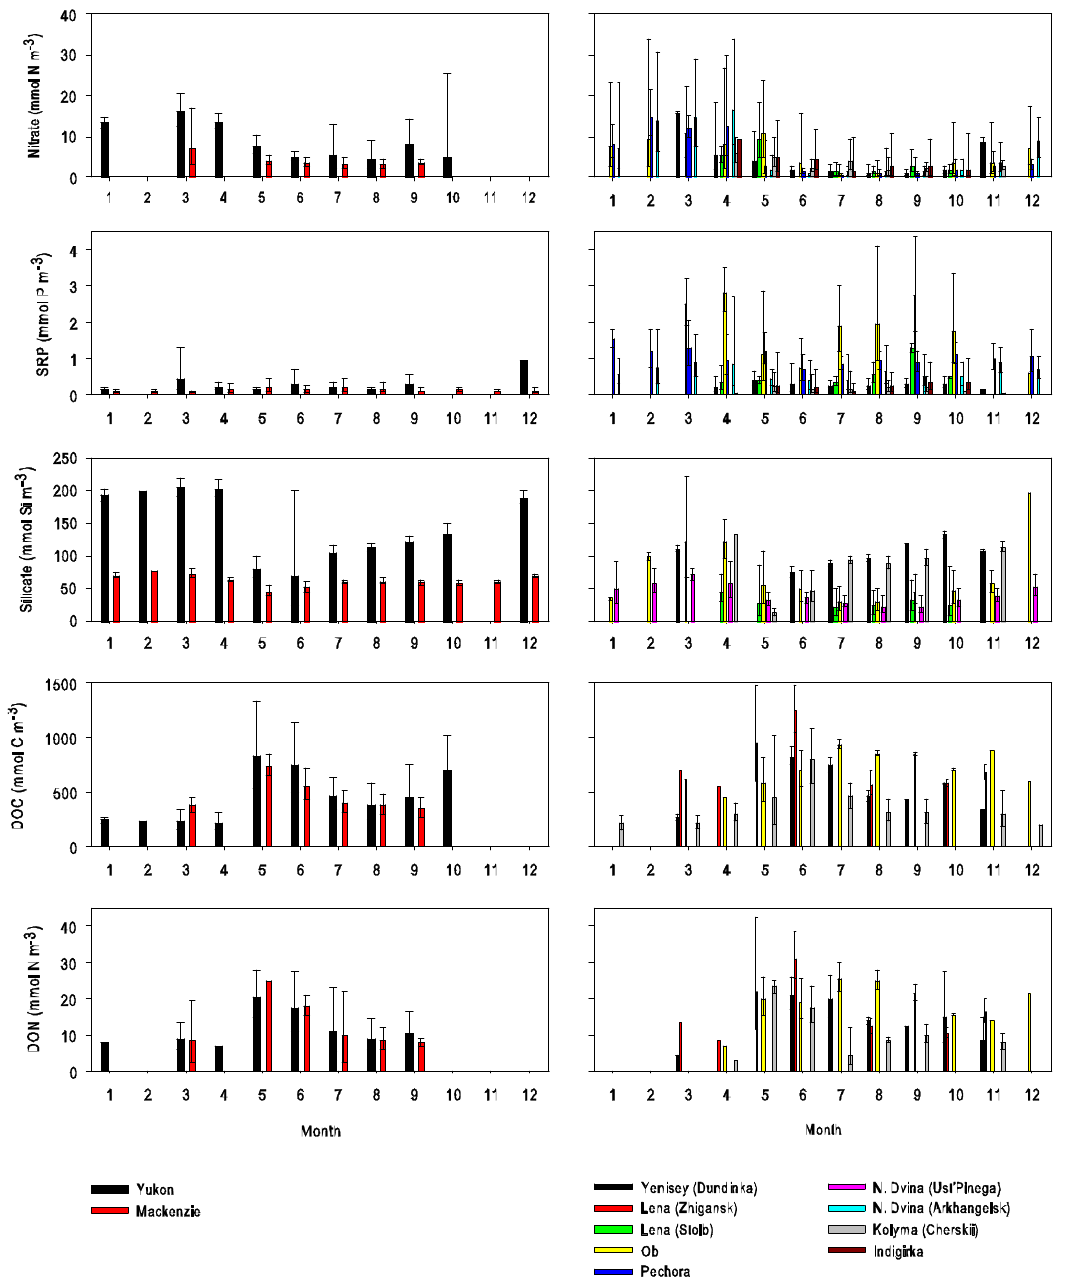
Fig. 1. Monthly-binned concentrations of riverine nitrate, SRP, silicate, DOC and DON for the North American and Eurasian rivers. Bars with no standard deviations indicate single values. Non-filled bars indicate no data